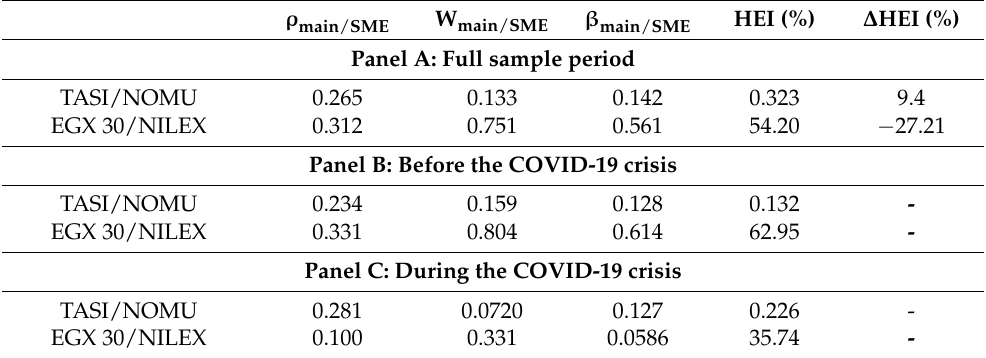
Table 6. Dynamic conditional correlations, optimal portfolio weights, hedge ratios and hedging effectiveness (%) for main–SME stock